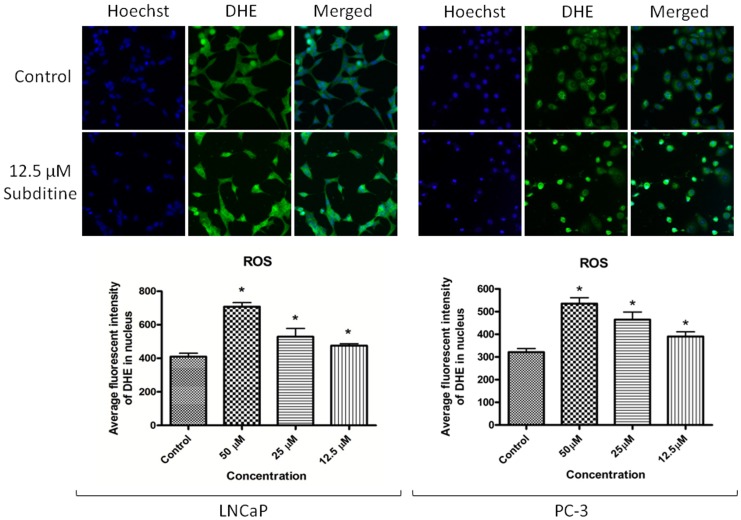
Subditine (1) enhanced ROS production in LNCaP and PC-3.LNCaP and PC-3 cells were treated with subditine (1) (12.5 µM, 25 µM, 50 µM) for 24 h. Cells were then fixed and stained with DHE dye. ROS levels were indirectly determined by measuring DHE dye incorporation in the nuclear using Cellomic HCS arrayscan. Increased DHE dye intensity in the nucleus was detected upon treatment of subditine. Hoechst (blue) and DHE dye (green). Bar chart showing the average fluorescent intensity of DHE stain (mean ± S.D.; *p<0.05).